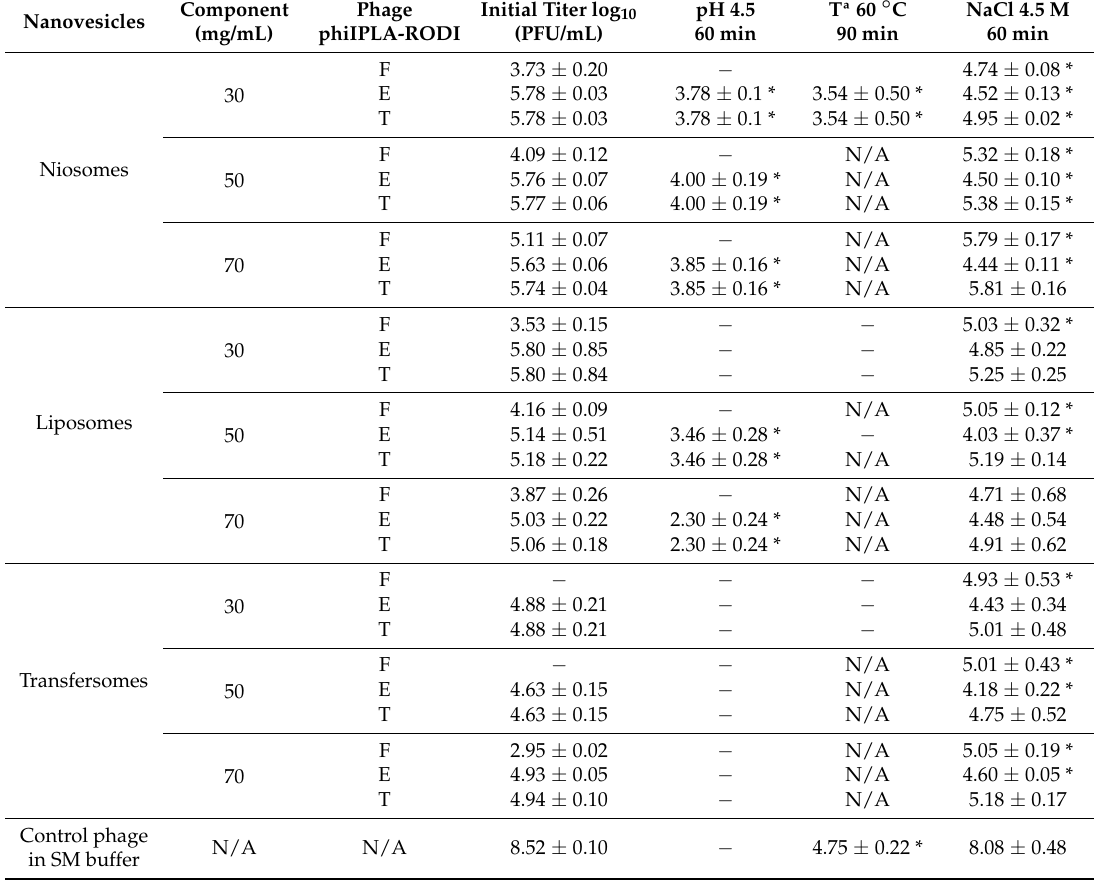
Table 3. Stability (log 10 PFU/mL) of bacteriophage phiIPLA-RODI to different